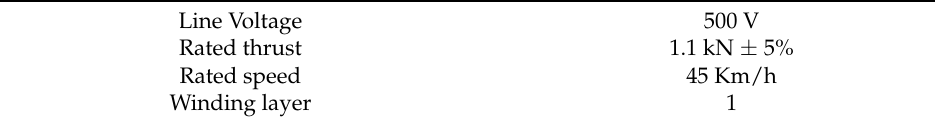
Table 1. Main indicators of SP-DLIM. Line Voltage 500 V Rated thrust 1.1 kN ± 5% Rated speed 45 Km/h Winding layer